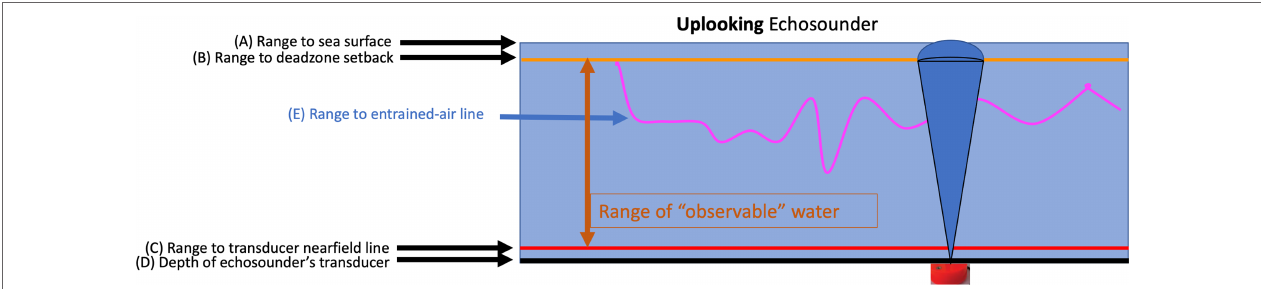
FIGURE 1 | Illustration of the boundaries defining the range of the observable water column for an upfacing echosounder. (A) Range to sea surface. (B) Deadzone setback: the range in which biomass within the acoustic beam is indistinguishable from the strong surface echo (Simmonds and MacLennan, 2005). (C) Nearfield line: a line set at a constant range to exclude the transducer “nearfield” in which the sound pulse is not yet organized (Simmonds and MacLennan, 2005). (D) Position of the upfacing transducer. (E) Entrained-air line: depth range of observable water is restricted to that not contaminated by entrained